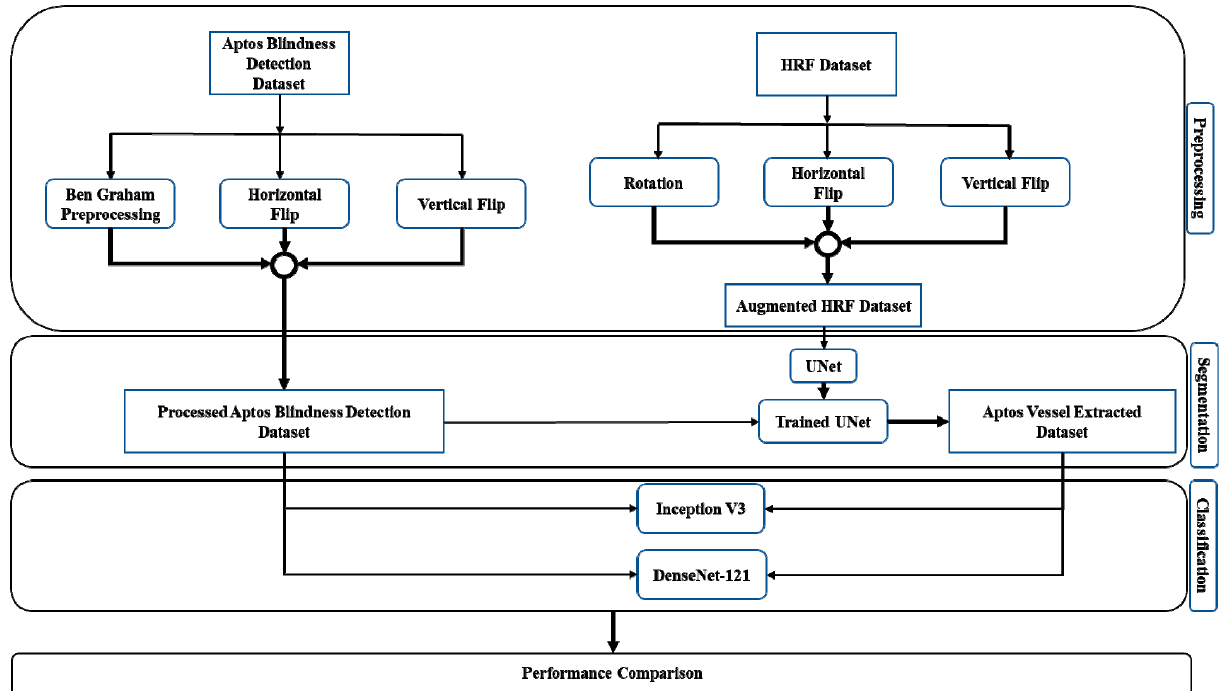
Figure 2. Block diagram of the proposed methodology.